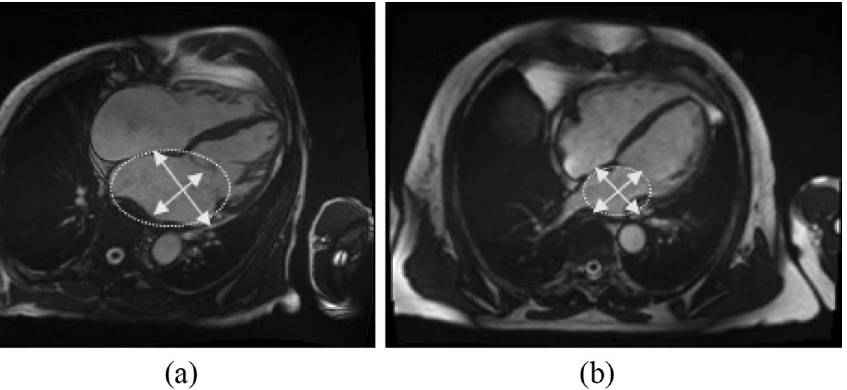
Figure 2. The figure shows four-chamber cine CMR images in end-diastole from two female UK Biobank participants. Our models selected the most important radiomics features from the left atrial region of interest. The arrows show the axis, and the circular shape indicates the sphericity. The first image ( a ) shows an AF patient with a larger axis and pronounced oval sphericity. The second image ( b ) illustrates a healthy subject with normal atrial dimensions, with more circular sphericity and a smaller axis than an AF patient.